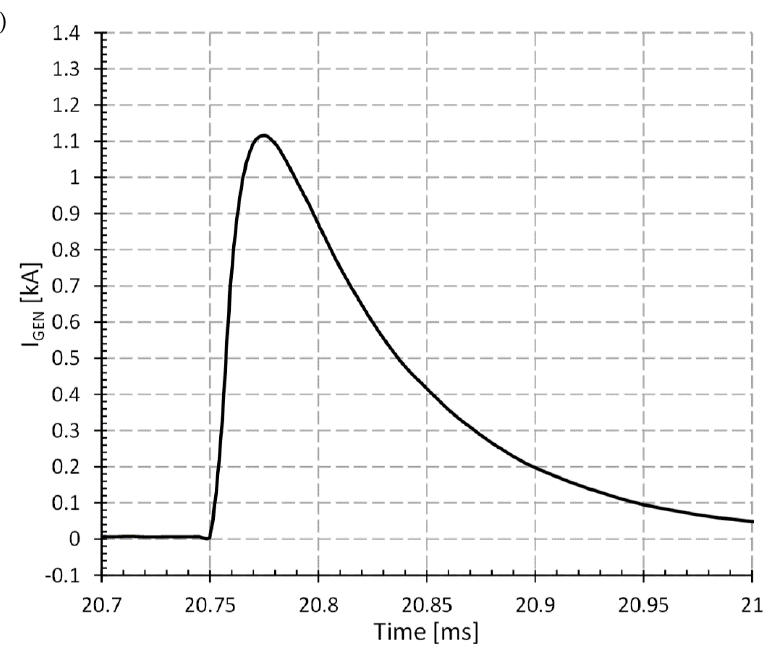
Figure 8. The current waveform injected to the system for case A: ( a ) full time scale; ( b ) enlarged time scale.